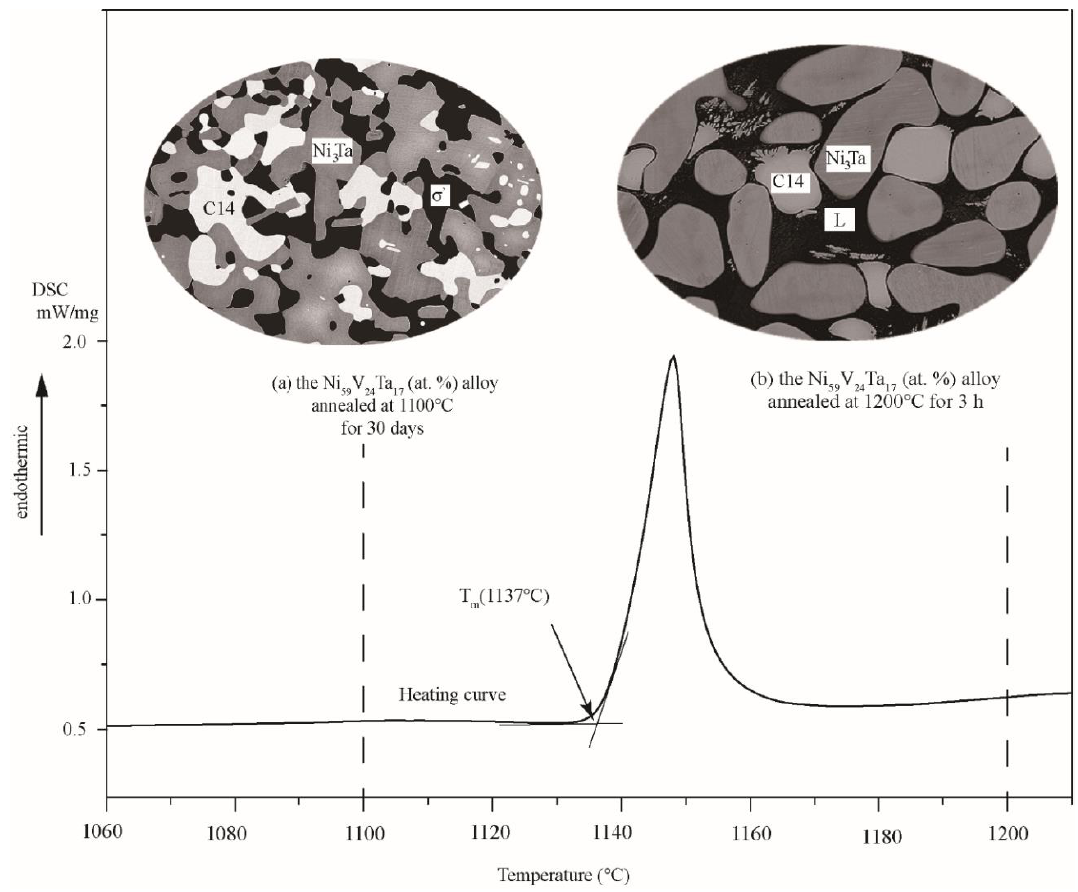
Figure 8. Heating curve of the Ni 59 V 24 Ta 17 alloy. The microstructure of the Ni 59 V 24 Ta 17 alloy annealed at ( a ) 1100 °C for 30 days; ( b ) 1200 °C for 3 h.